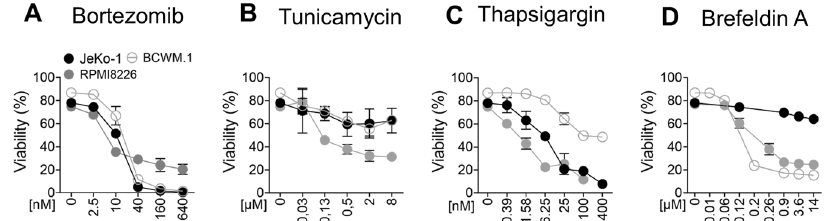
Fig. 1 Distinct ER stress cell death sensitivities in B-cell malignancy cell lines. A – D JeKo-1, RPMI8226 and BCWM.1 cells were plated at 0.4×10 6 cells/ml with the indicated drugs and doses for 24 hours. Viability was measured via FACS using DiOC6 and ToPro-3 staining. DiOC6 + and ToPro-3- cells were considered viable. Results are shown as Mean ± SEM ( N =